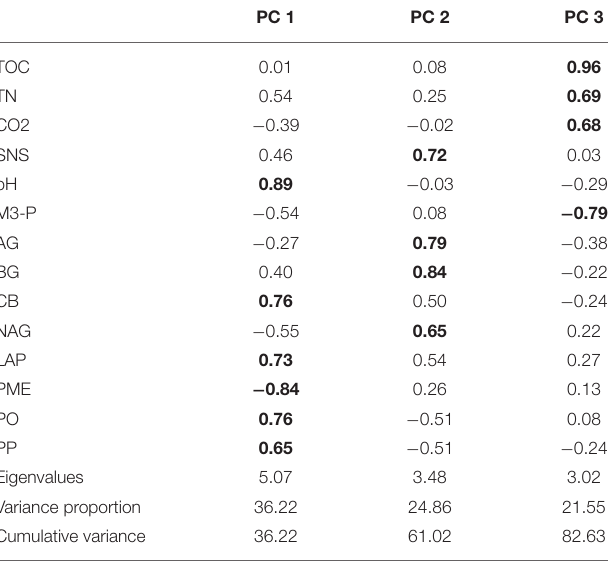
TABLE 8 | Principal component analysis using overall means from all study